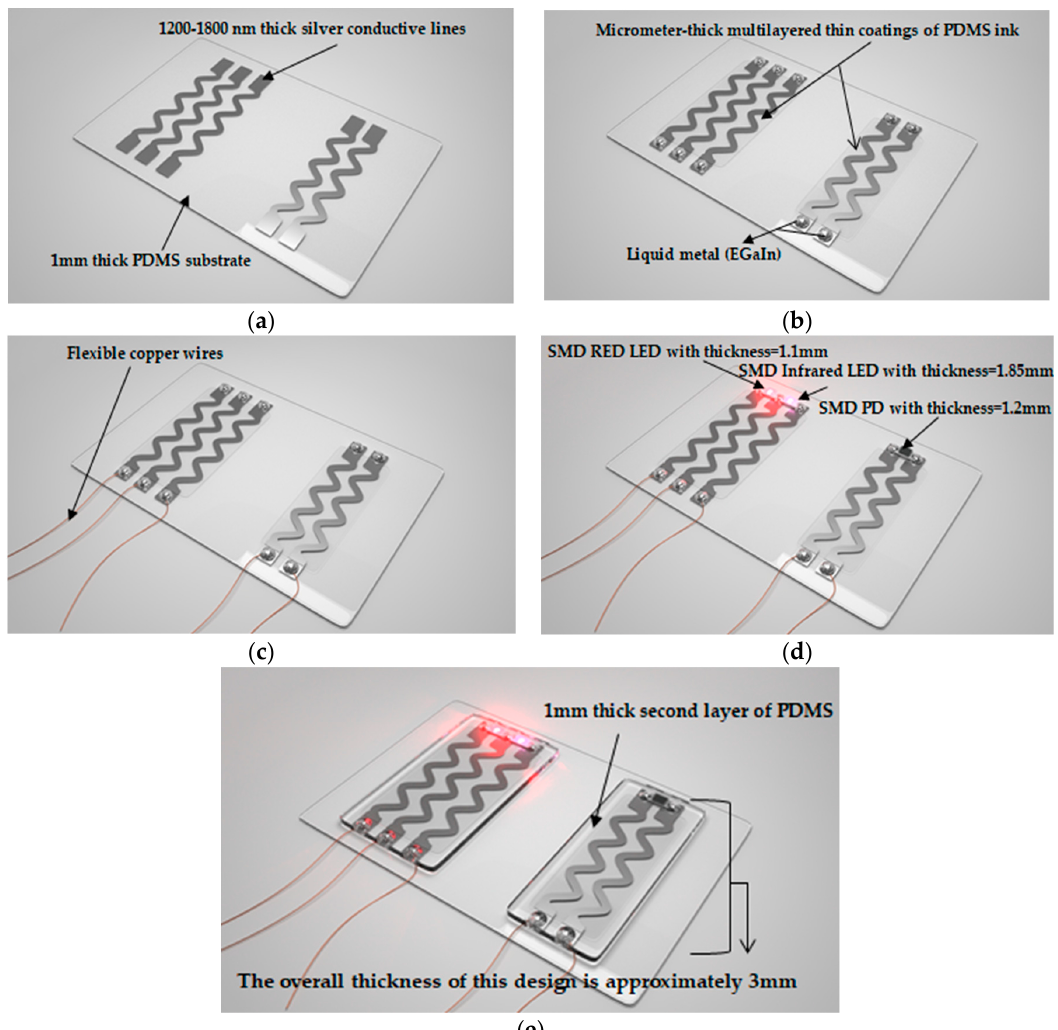
Figure 6. Steps for developing a fully stretchable sensor. ( a ) Sinusoidal silver conductive lines are printed on top of plasma-treated PDMS; ( b ) a protective coating of PDMS ink is inkjet-printed on top of the lines, and non-hazardous liquid metal (EGaIn, Sunnyvale, CA, USA) is incorporated for purposes of power transmission and signal acquisition; ( c ) flexible copper wires are inserted in liquid metal; ( d ) surface mount LEDs and PD are loaded on top of liquid metal; ( e ) uncured PDMS is poured to form a second layer of PDMS covering the circuit, optoelectronics, and wire connections.